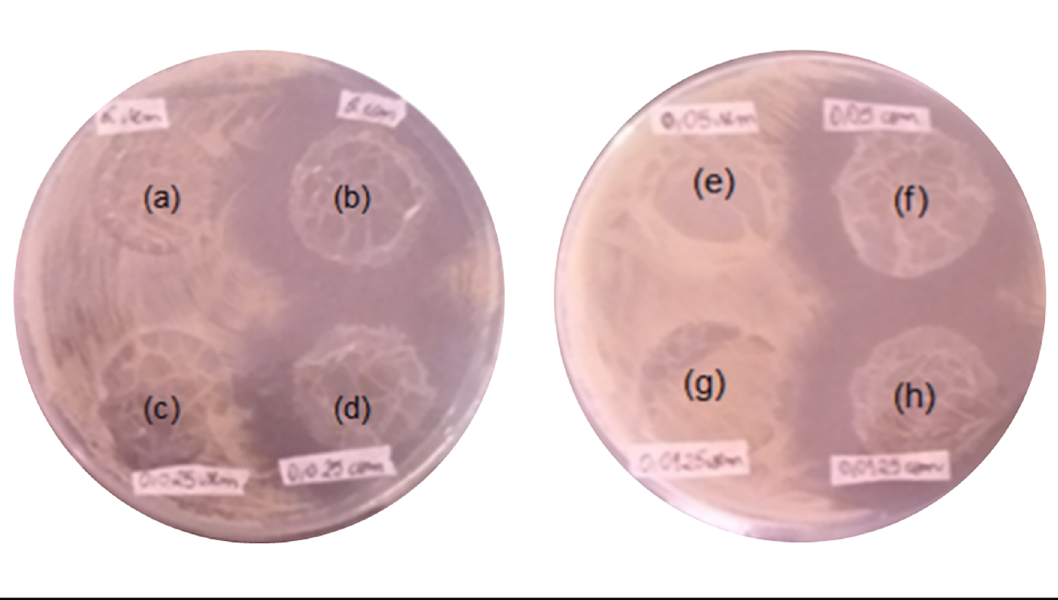
Figure 9. Antibacterial activity of (a) CHI; (b) CHI-GE; (c) 1/4 mPEG-PCL/ CHI-GE; (d) 1/4 mPEG-PCL/ CHI; (e) 1/2 mPEG-PCL/ CHI; (f) 1/2 mPEG-PCL/ CHI-GE; (g) 1/8 mPEG-PCL/ CHI and (h) 1/8 mPEG-PCL/ CHI - GE against S.